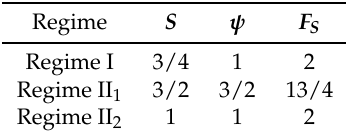
Table 1. Exponents of R ≡ Ra − 1 in the power-law scalings of S , ψ and the salinity flux F S in Regimes I and Sub-regimes II 1 and II 2 for small and large R ,